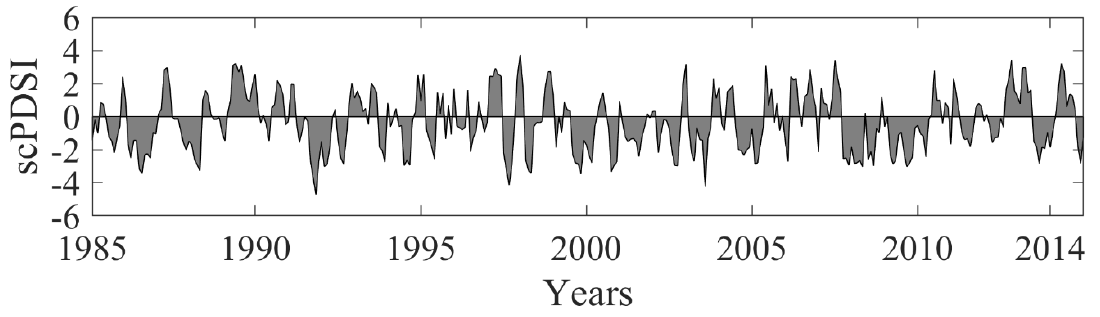
Figure 17. Grid-averaged scPDSI values from 1985 to 2014 for study area KSB based on historic observed data.